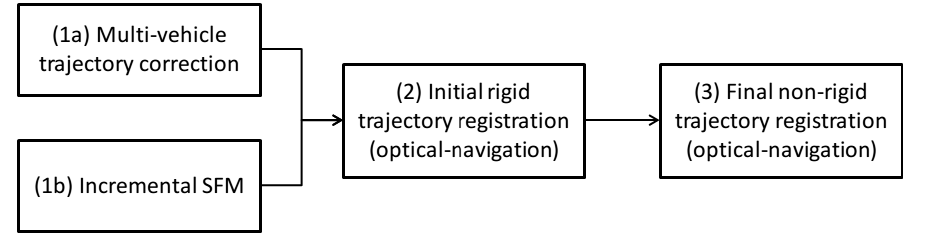
Figure 2. The processing pipeline presented in this article: Steps (1a), (1b), (2) and (3) correspond to Sections 4, 5.1, 5.2.1 and 5.2.2 respectively. Steps (1a) and (1b) can run in parallel, as they do not need to share